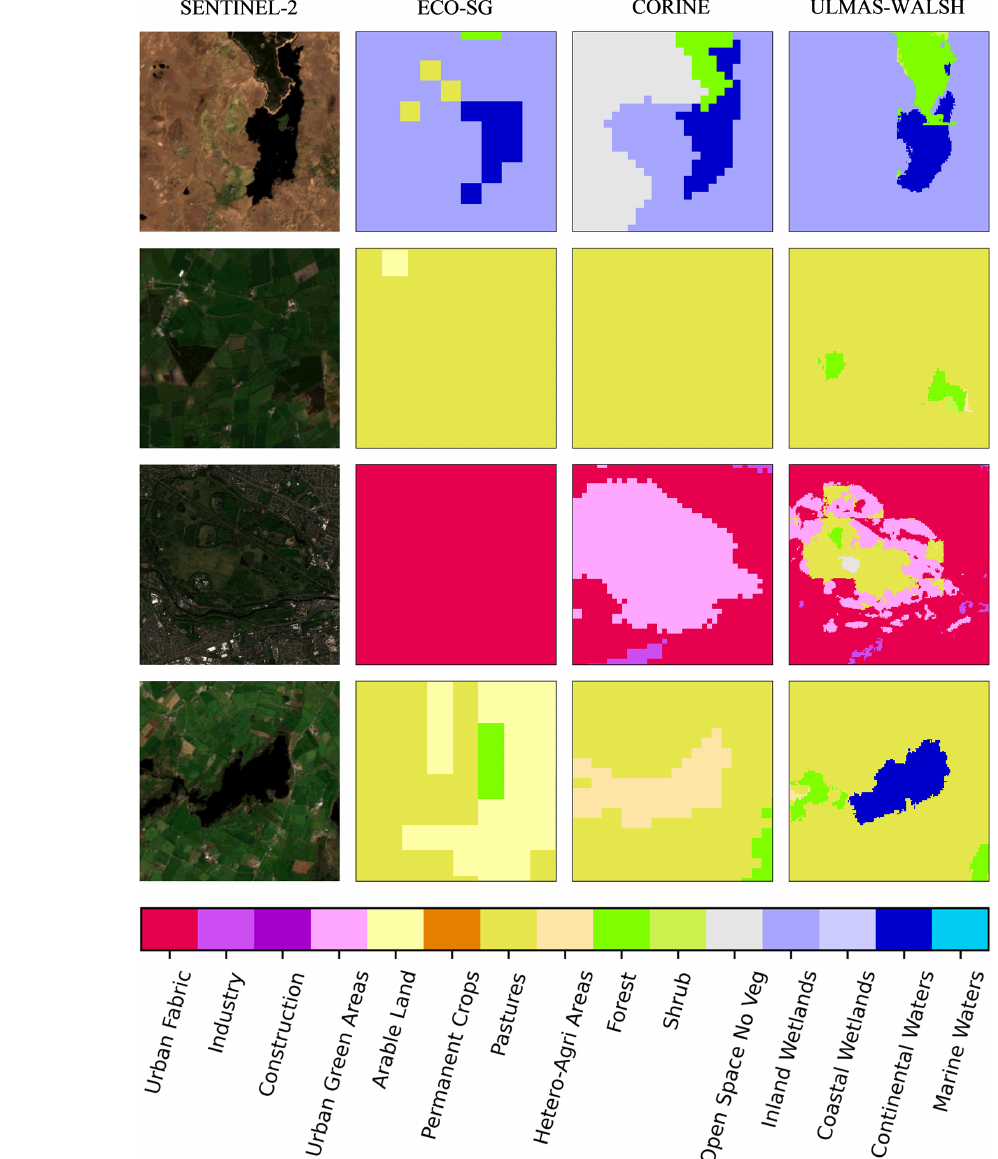
Figure 11. Satellite image segments and the corresponding ECO-SG, CORINE and UW cover maps for these images with secondary CORINE land-cover labels. The same areas as in Fig. 7 are shown. The satellite images were produced from ESA remote sensing data.